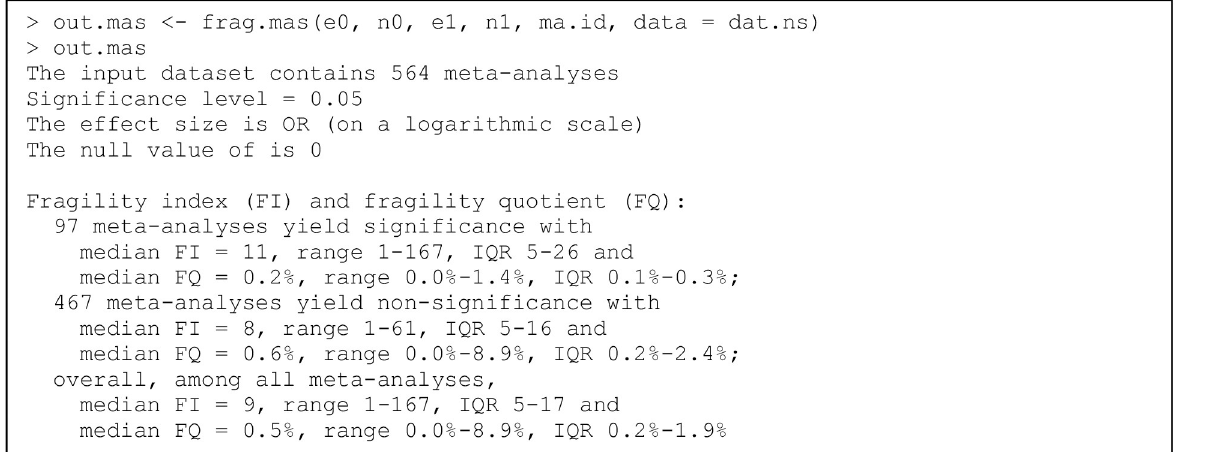
> plot(out.mas, max.f = 40, cex.name = 0.5) > plot(out.mas, fragility = “FQ”, breaks = 20) The first line produces the bar plot of FIs of all 564 MAs in Fig 12a, and the second line pro- duces the histogram of FQs in Fig 12b. As displayed in the output of out.mas , the FIs may take large values up to 167, so max.f is specified as 40 for truncation. Most MAs have FIs less than 15 and FQs less than 1%.